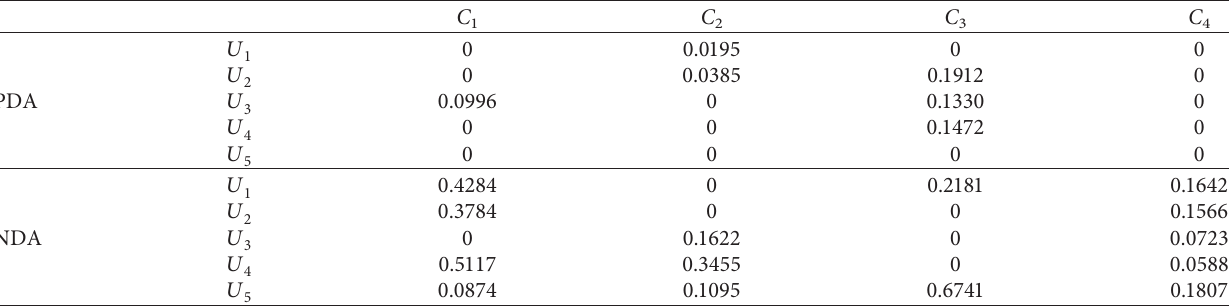
Table 10: The matrix of PDA and NDA.